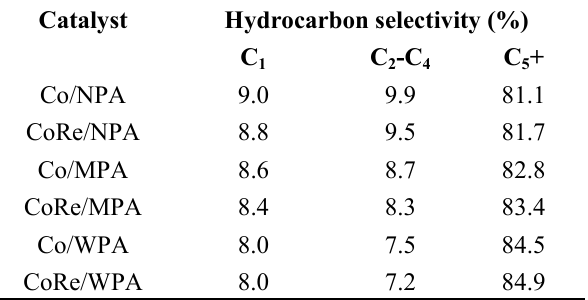
/CO = 2, and X of 2 CO O 2 3